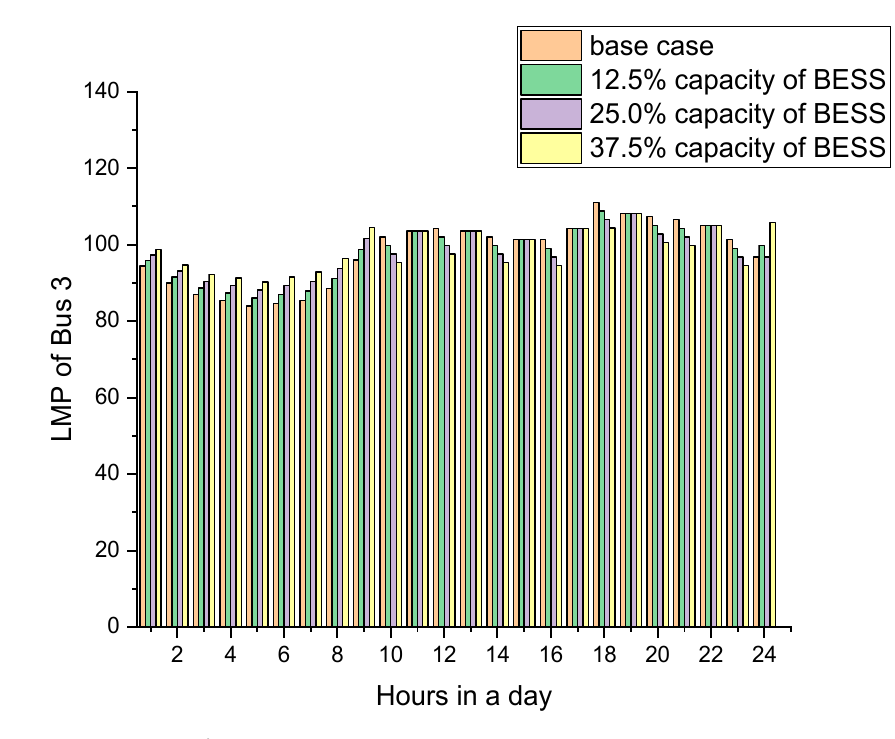
Table 5. Change in Revenue of GenCos as compared to Base Case.